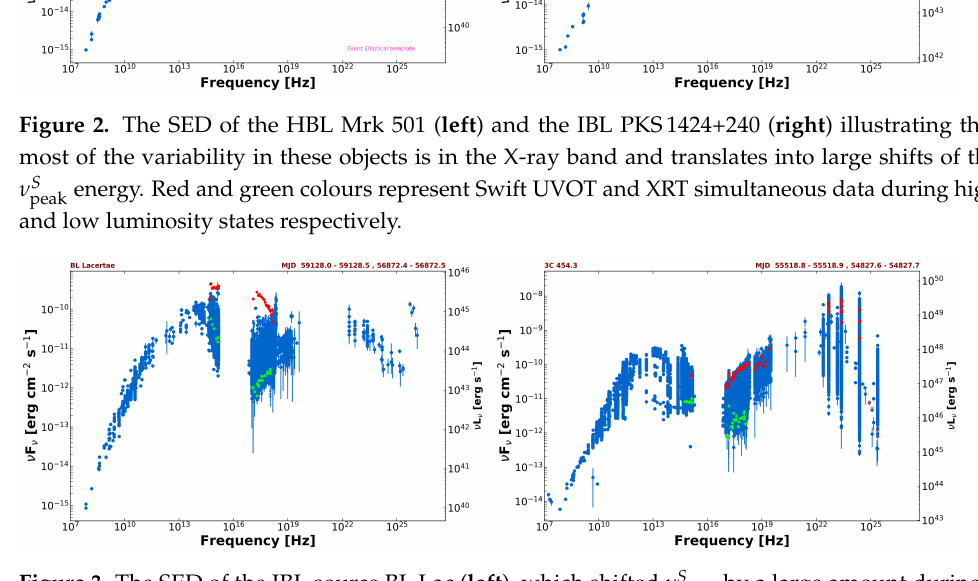
Figure 3. The SED of the IBL source BL Lac ( left ), which shifted ν S by a large amount during a peak strong flare, and the LBL blazar 3C 454.3 ( right ), which shows large variability of similar amplitude from far IR to the X-ray band, and no large ν S shift. Red and green colours represent Swift UVOT peak and XRT simultaneous data during high and low luminosity states